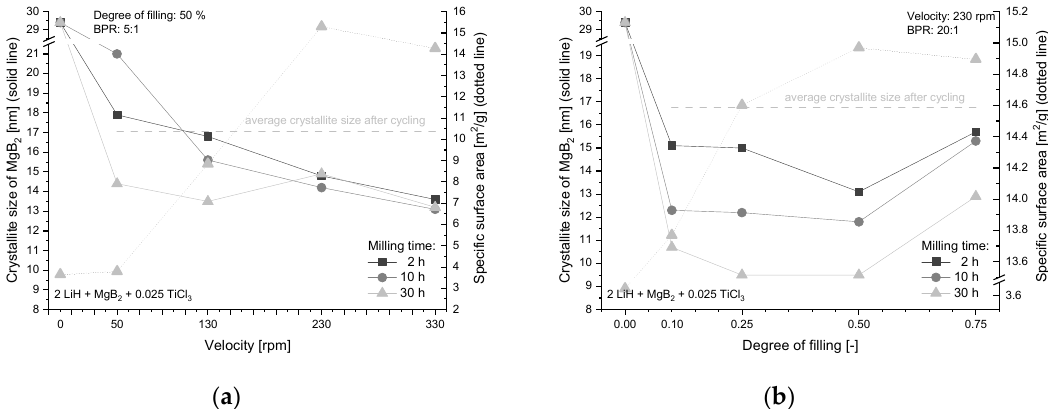
Figure A1. Crystallite size of MgB 2 (calculated) and specific surface area of powders, as a function of ( a ) the milling velocity and of ( b ) the degree of filling, for different milling times.